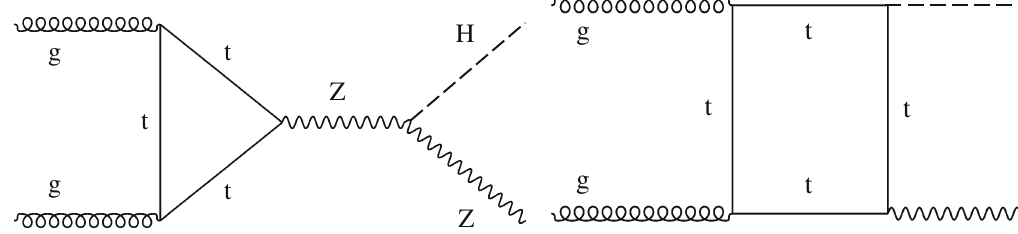
Fig. 4 Examples of leading-order Feynman diagrams for tH production via the tHW (upper left and right) and tHq (lower)